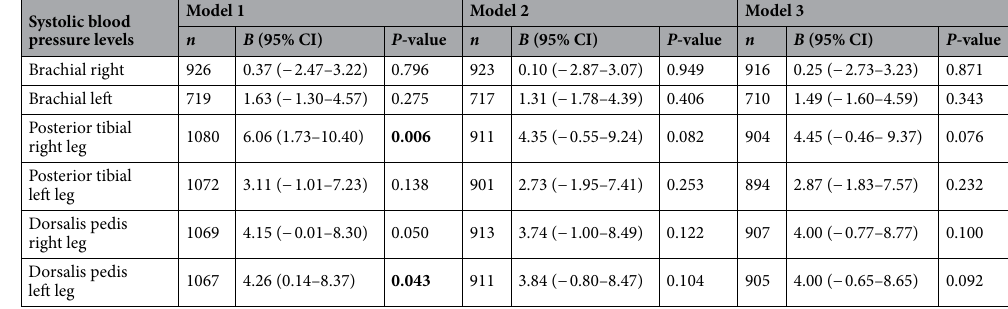
Table 5. Associations between blood pressures and diabetes status: Ankle pressure is a better discriminator than brachial for diabetes. Model 1: adjusted to age and sex; Model 2: adjusted age, sex, BMI, waist height ratio, ethnicity; Model 3: adjusted age, sex, BMI, waist height ratio and European and South Asian groups.